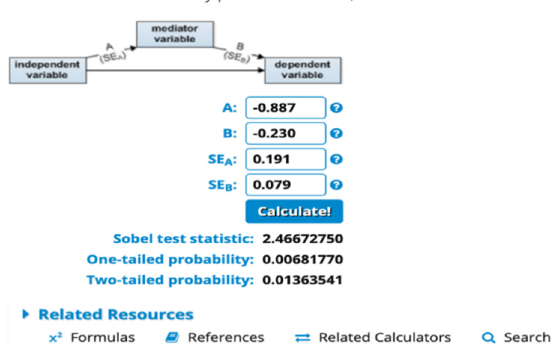
Figure 4. Sobel Test Result of FDQ → Earnings Management → Sukuk Rating. Source: Sobel Test Output, available online: https://www.danielsoper.com/statcalc/calculator.aspx?id=31, accessed on 5 January 2022.